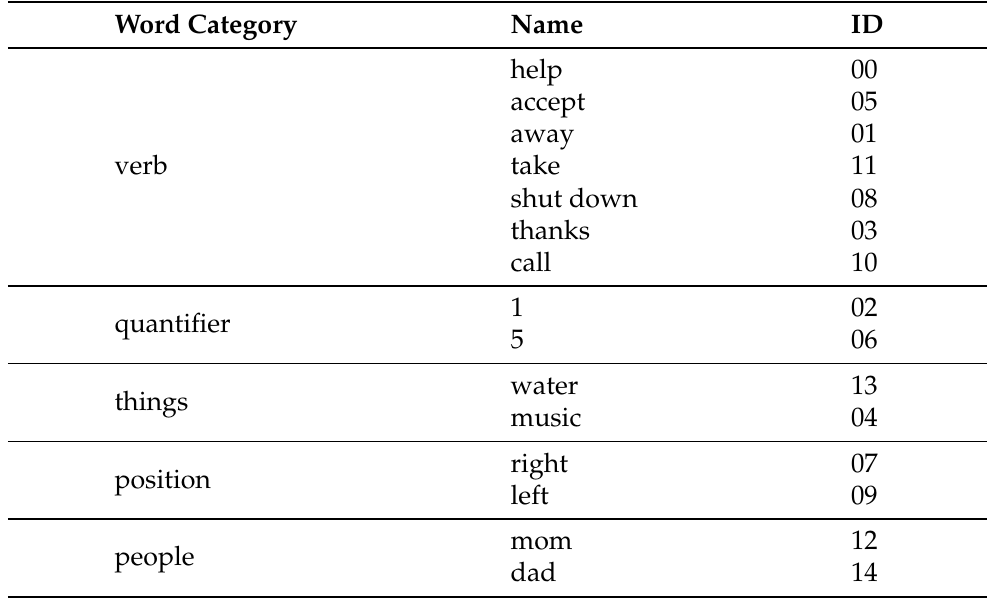
Table 1. The division of the part of our sign language datasets and the corresponding display of categories and serial